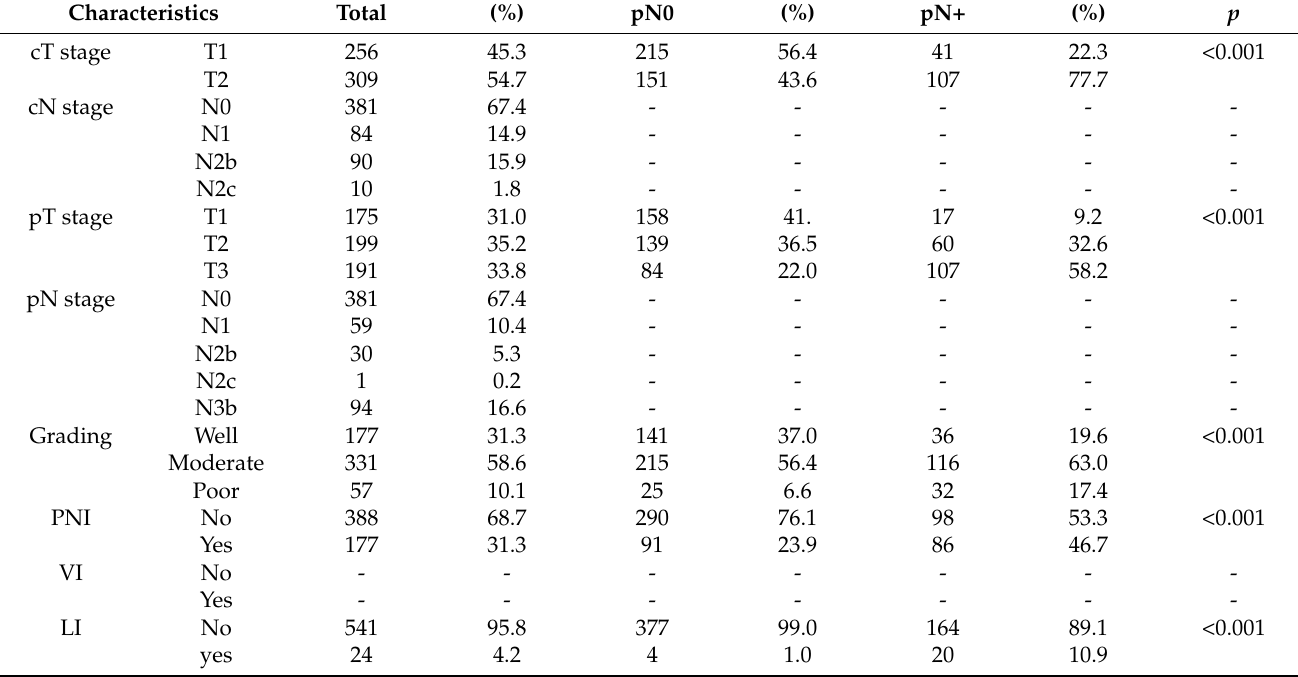
Table 1. Patient’s clinical data and pathological characteristics.